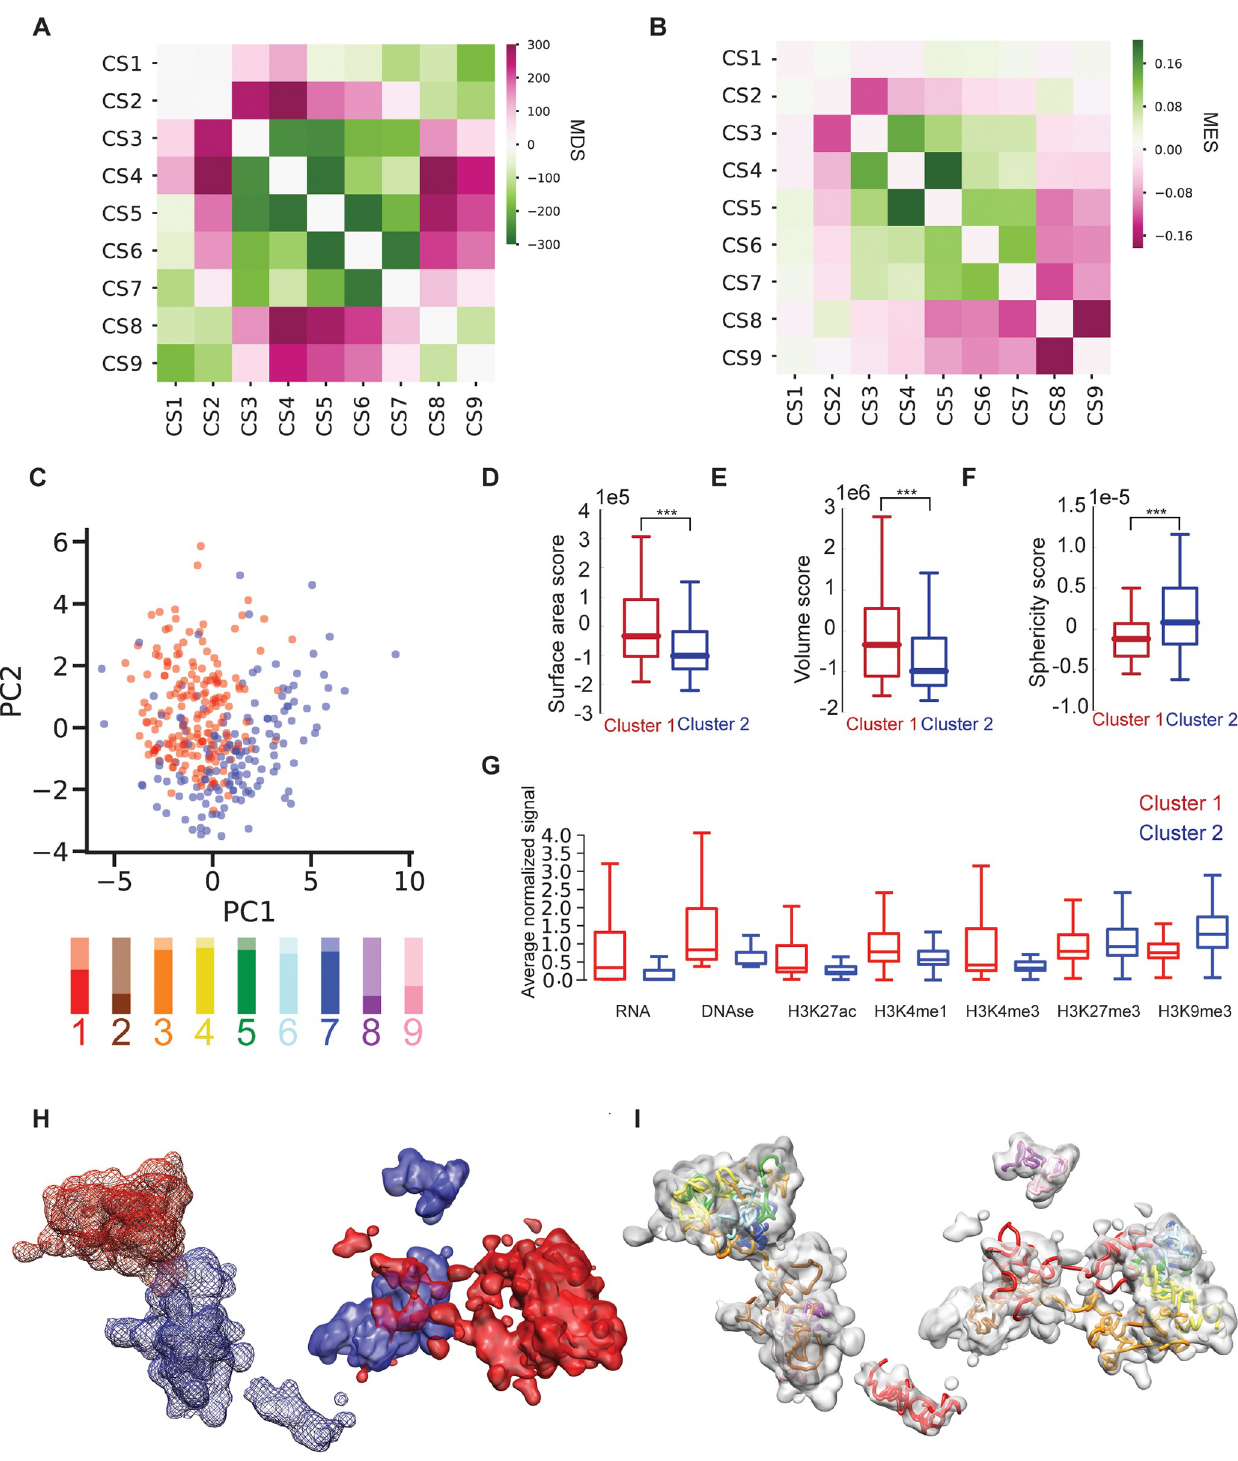
Fig 3. Image analysis and integrative modeling. ( A, B ) Matrices for ( A ) mean spatial distance scores (MDS) and ( B ) mean entanglement scores (MES) for CS1-9. ( C ) Unsupervised PCA of 3D features for the 342 visualized chromosomal segments suggests two major clusters. Score plot for chromosomal segments color-coded by cluster type: cluster 1 in red and cluster 2 in blue. Lower panel, proportion of images of each chromosomal segment in cluster 1 (opaque color) or cluster 2 (transparent color); the chromosomal segments are colored as in Fig 2A and 2B. ( D-F ) Variation and distribution of the two clusters in terms of ( D ) surface area, ( E ) volume, and ( F ) sphericity scores are shown as box plots, where boundaries represent 1st and 3rd quartiles, middle